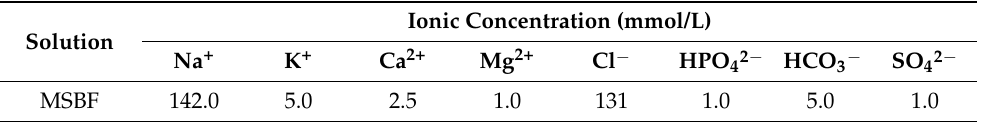
Table 2. Composition of the modified simulated body fluid (MSBF).